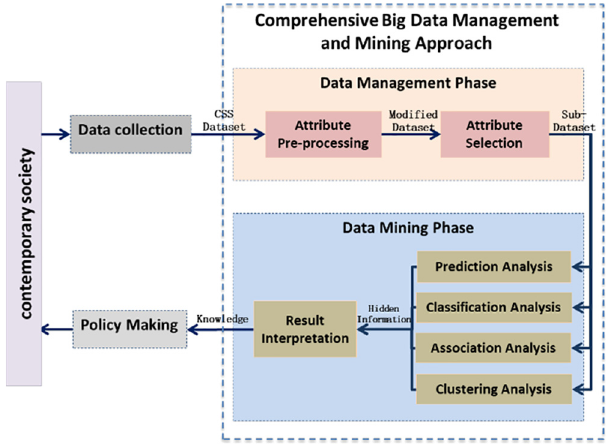
Figure 1. The architecture